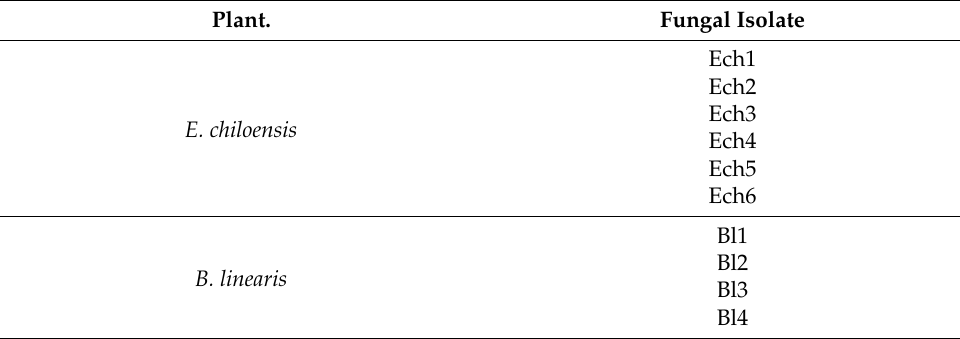
Figure 2. Antifungal effect of isolate Bl1 (black bar) and isolate Ech4 (grey bar) on B. cinerea growth. Each bar represents the average inhibition percentage of three experiments ± SD. Statistical signifi- cance when comparing treated groups and control group by multiple t-tests and Holm-Sidak method are indicated with asterisks ( p < 0.05).